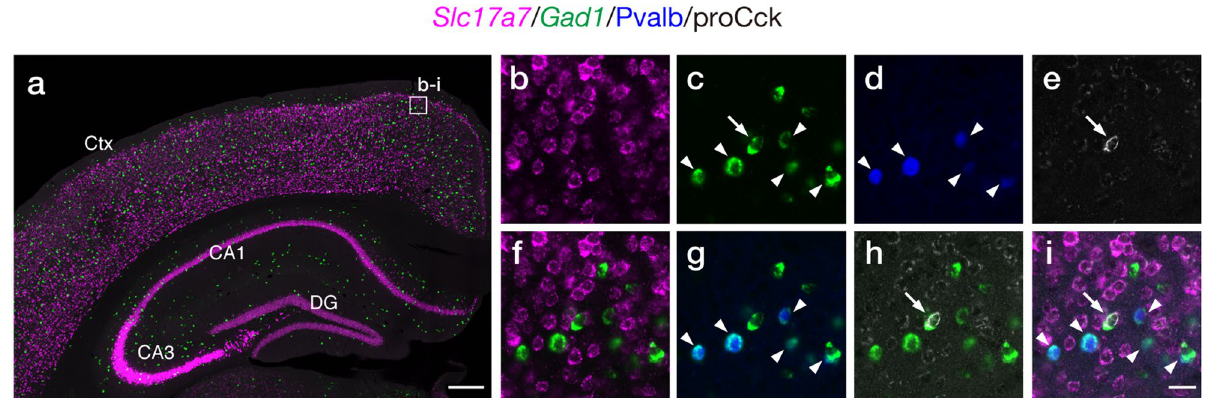
Figure 6. Fluorescence quadruple labeling with multiplex FT-GO FISH and IF. (a) Slc17a7 (magenta) and Gad1 (green) FT-GO mRNA FISH in the mouse brain (n = 3 animals). ( b–e) Representative images of quadruple labeling for Slc17a7 mRNA ( b ), Gad1 mRNA ( c ), Pvalb protein (blue, d ) and proCck peptide (gray, e ) in the rectangle in ( a ). ( f–h) Double merged images of Slc17a7 and Gad1 ( f ), Gad1 and Pvalb ( g ), and Gad1 and proCck ( h ). ( i) A quadruple merged image of Slc17a7 , Gad1 , Pvalb, and proCck. CF488A and CF568 tyramide are used for color development of Gad1 and Slc17a7 hybridization signals. Pvalb- and Cck-positive GABAergic interneurons are indicated by arrowheads and arrows, respectively. CA1 cornu ammonis 1, CA3 cornu ammonis 3, Ctx cerebral cortex, DG dentate gyrus. Scale bars: 300 µm in ( a ) and 25 µm in ( i ).